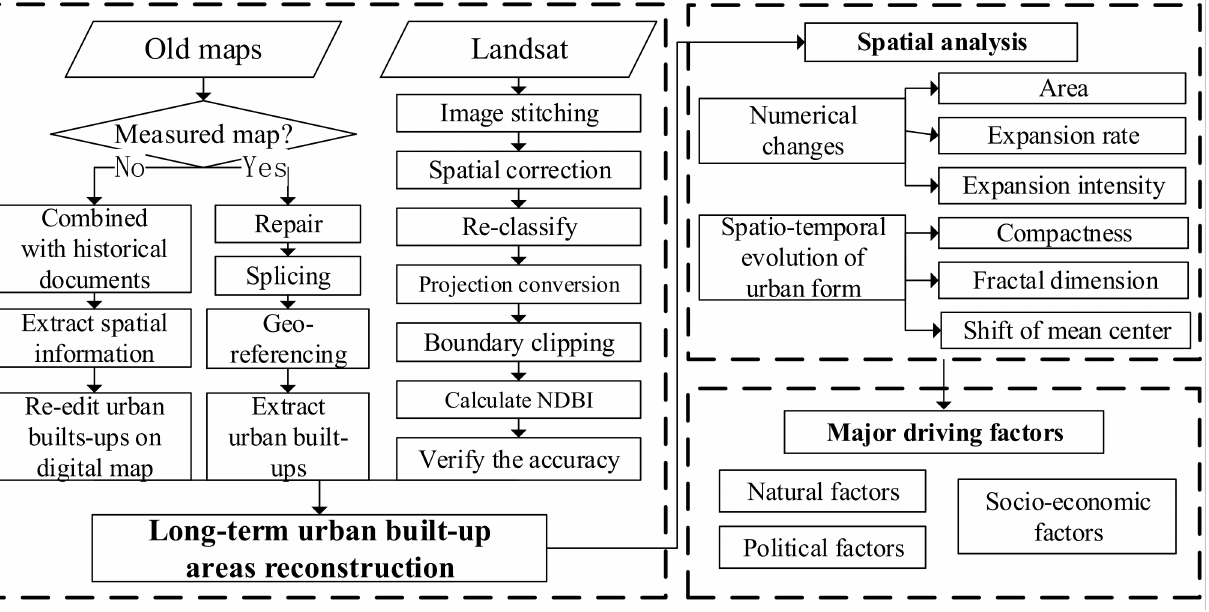
Figure 4. The flowchart of this